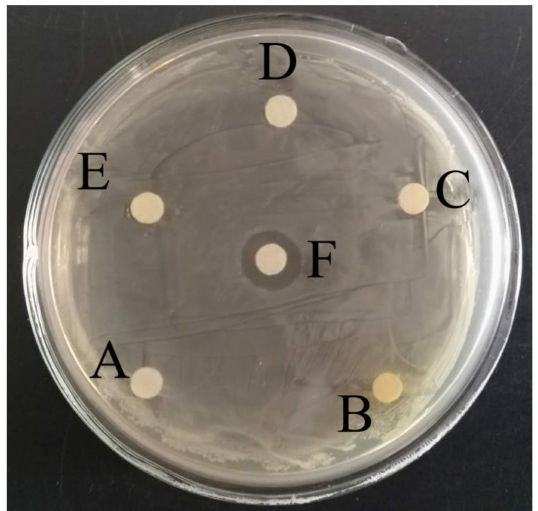
Figure 3. The antibacterial activity of filter paper immersed in licorice extract in 2% (D), 4% (C), 8% (E) and 20% (B) solid content, penicillin and streptomycin mixture (positive control, F) and sterile saline (negative control,